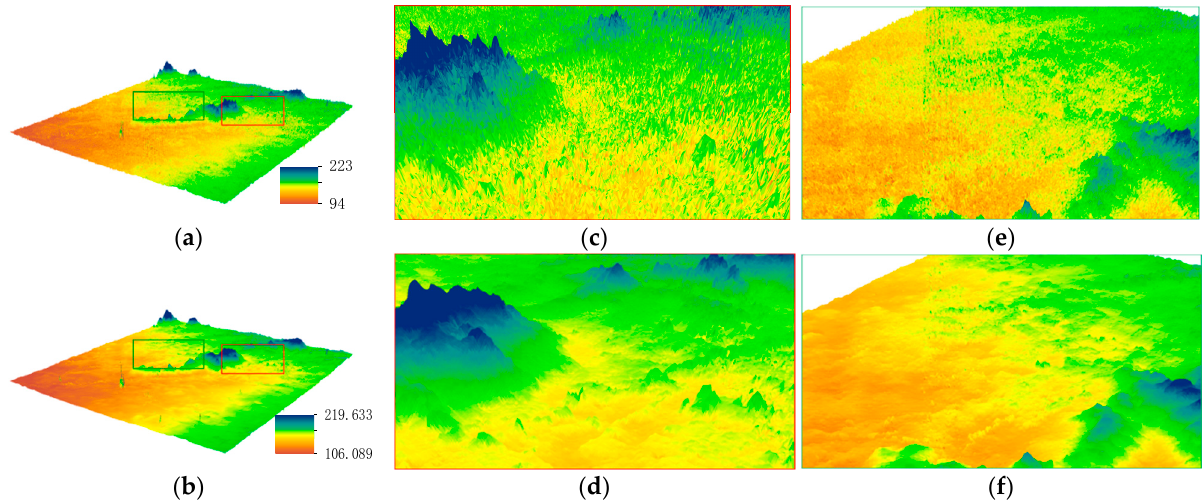
Figure 1. Area S30E148 in Shuttle Radar Topography Mission 1 (SRTM 1) containing spikes, speckles and multidirectional stripe errors (unit: meter). ( a ) The original data, ( c ) the local enlargement of the spike-error area and ( e ) the local enlargement of the mixed-error area. The second column ( b , d , f ) contains the data corresponding to panels a, c and e, respectively, after removing the errors using the proposed low-rank group-sparse method (LRGS).